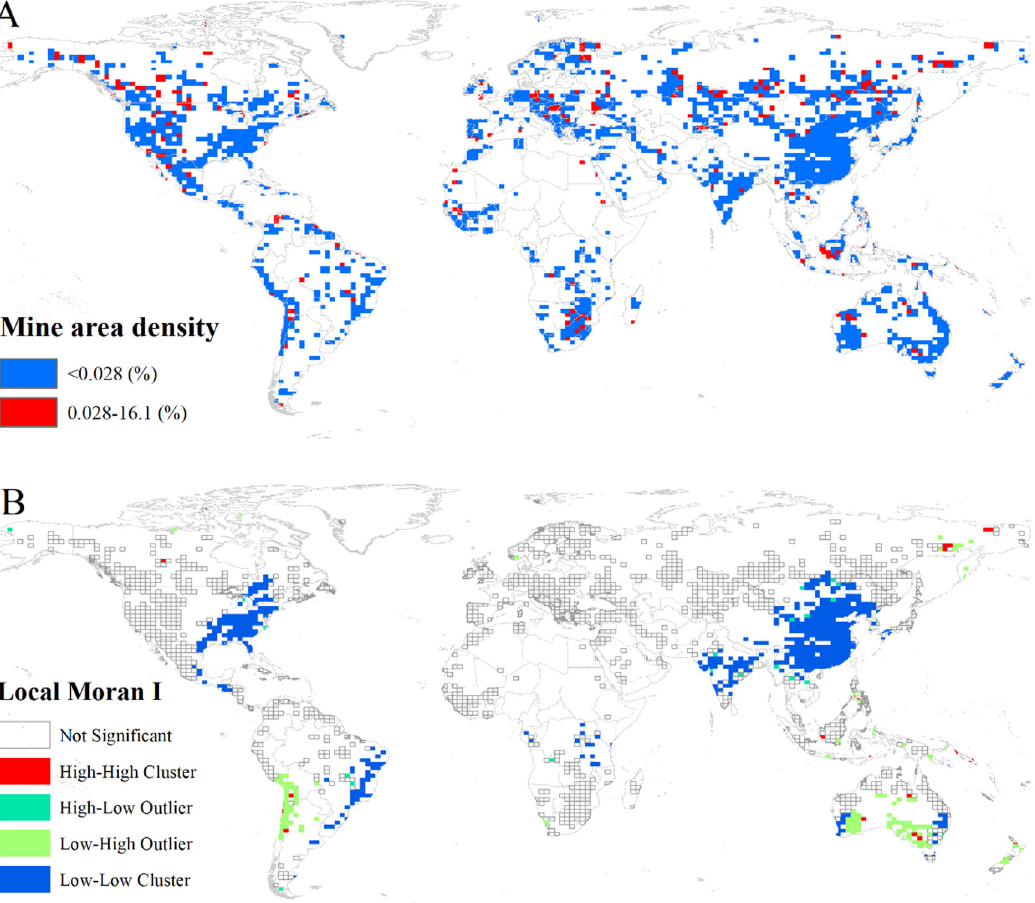
Fig. 2 Spatial heterogeneity of global mine areas. Global Moran ’ s I index = 0.115, z -score = 240, p value < 0.001. Mine areas are aggregated to 8653 fi shnet cells (15,400 km 2 per cell, with some cells bisected due to irregular coastal borders) projected to Interrupted Goode Homolosine. A The global distribution density of mapped mining areas; B Anselin Local Moran ’ s I 55